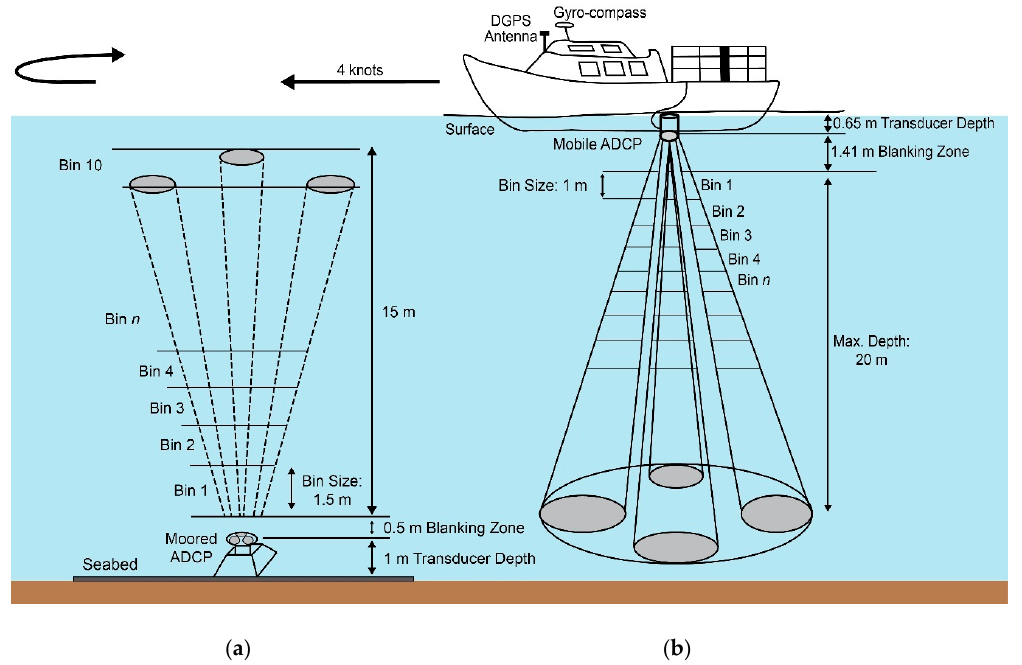
Figure 2. The zooplankton acoustic acquisition setting on (a) moored ADCP and (b) mobile ADCP. The mobile ADCP moving through the pre-defined cross-section showed with arrows and passed moored ADCP location, turned back in the same track, and repeated for 3 hours of each session (daylight, twilight, and